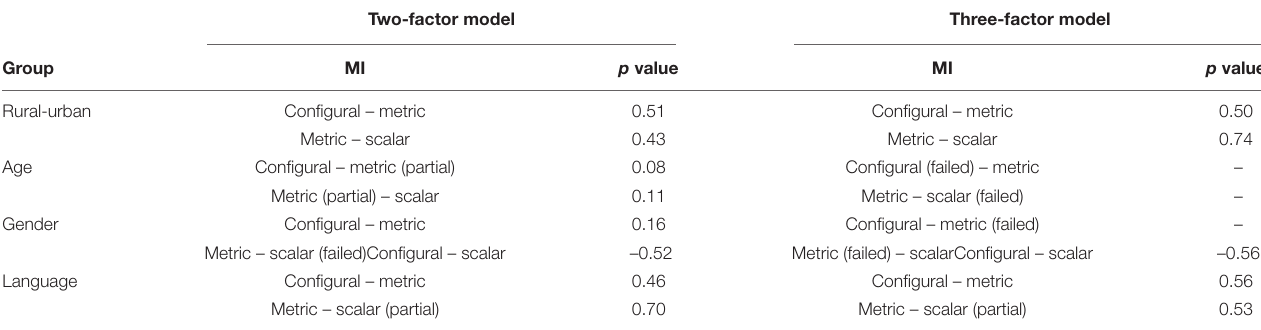
TABLE 6 | Measurement